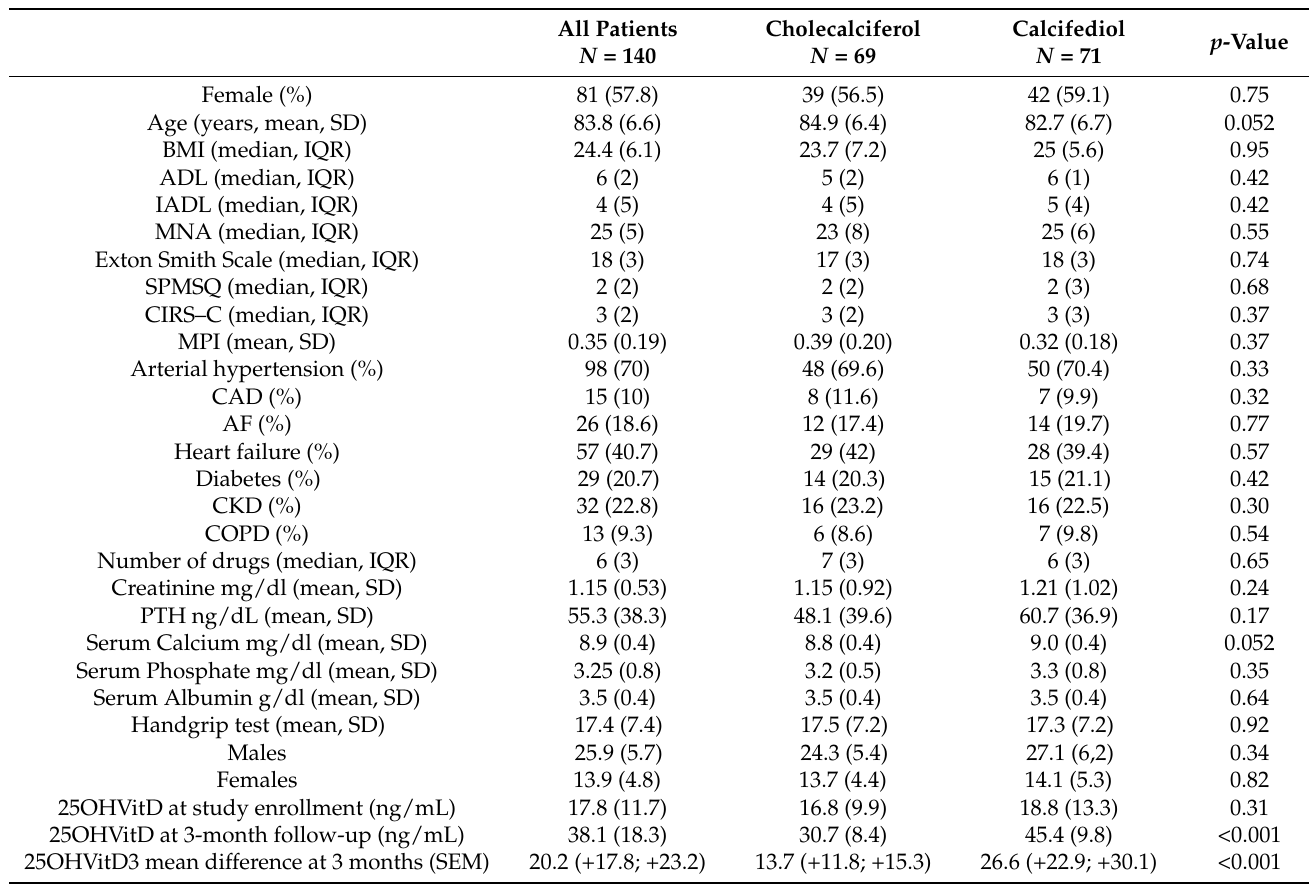
Figure 1. Flowchart of study enrollment. Table 1. Clinical characteristics of the study